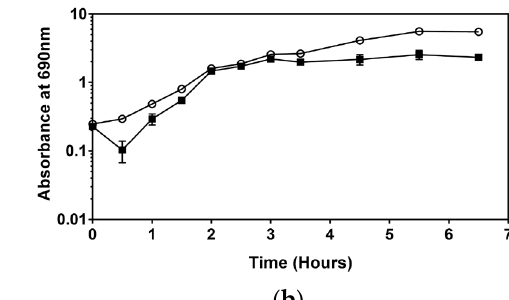
Figure 1. Growth comparison of supplementation with sub-MIC levels of benzalkonium chloride (●) and without BAC ( ○ ). For some points, the error bars are shorter than the height of the symbol. In these cases, the error bars were not drawn: ( a ) Serratia marcescens ATCC 13880; ( b ) Serratia sp. HRI.